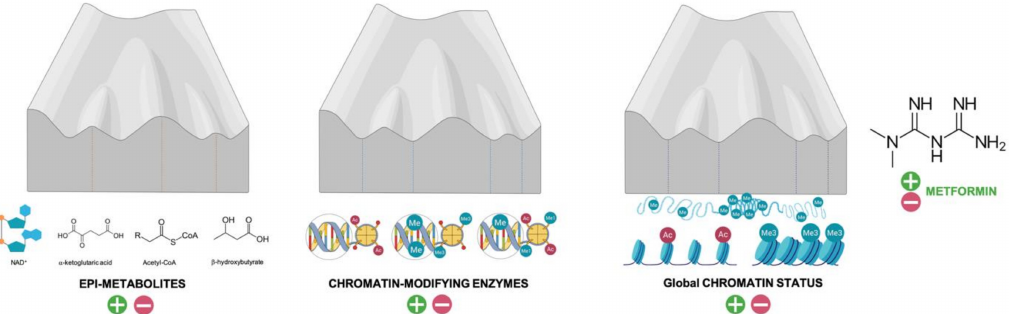
Figure 2. Metformin maintenance of the epigenetic landscape. The height and steepness of hills between two valleys determine, at least in part, the ability of the epigenome to modulate phenotypic plasticity and canalization during di ff erentiation. Metformin might prevent the undesirable interconversion of neighboring cellular epistates occupying adjacent valleys by fine-tuning both the provision of specific epi-metabolites and the activation status of chromatin-modifying enzymes that specify a given cell type, i.e., two key shapers of the Waddington’s epigenomic landscape. As a consequence, metformin might halt the erosion of the epigenetic landscape and delay age-associated epigenetic drift, i.e., the gradual decrease of global DNA methylation leading to the alteration of epigenetic